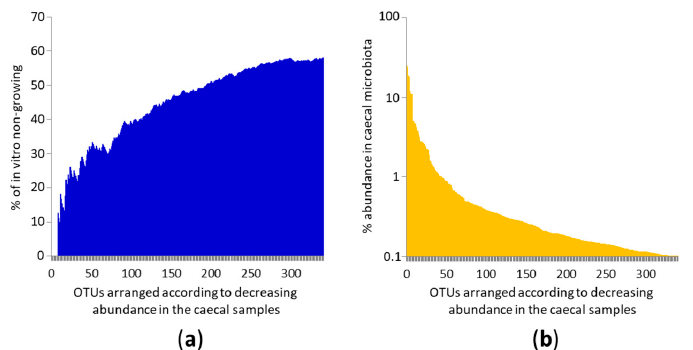
Figure 1. Ability of in vitro growth of the most frequent OTUs colonising the chicken caecum. ( a ). Individual OTUs are arranged on the X axis according to their decreasing abundance in chicken gut microbiota. Y axis shows the proportion of non-growing OTUs. The most common OTUs grew in vitro and their ability to grow in vitro decreased as OTUs became less common. ( b ) X axis shows the same values as in panel ( a ) and the Y axis shows the abundance of a given OTU in the caecal microbiota. Each of the top 45 OTUs formed more than 1% of total microbiota in at least one of six caecal samples used as inocula for in vitro culture. Mind the logarithmic scaling of the Y axis in panel ( b ).